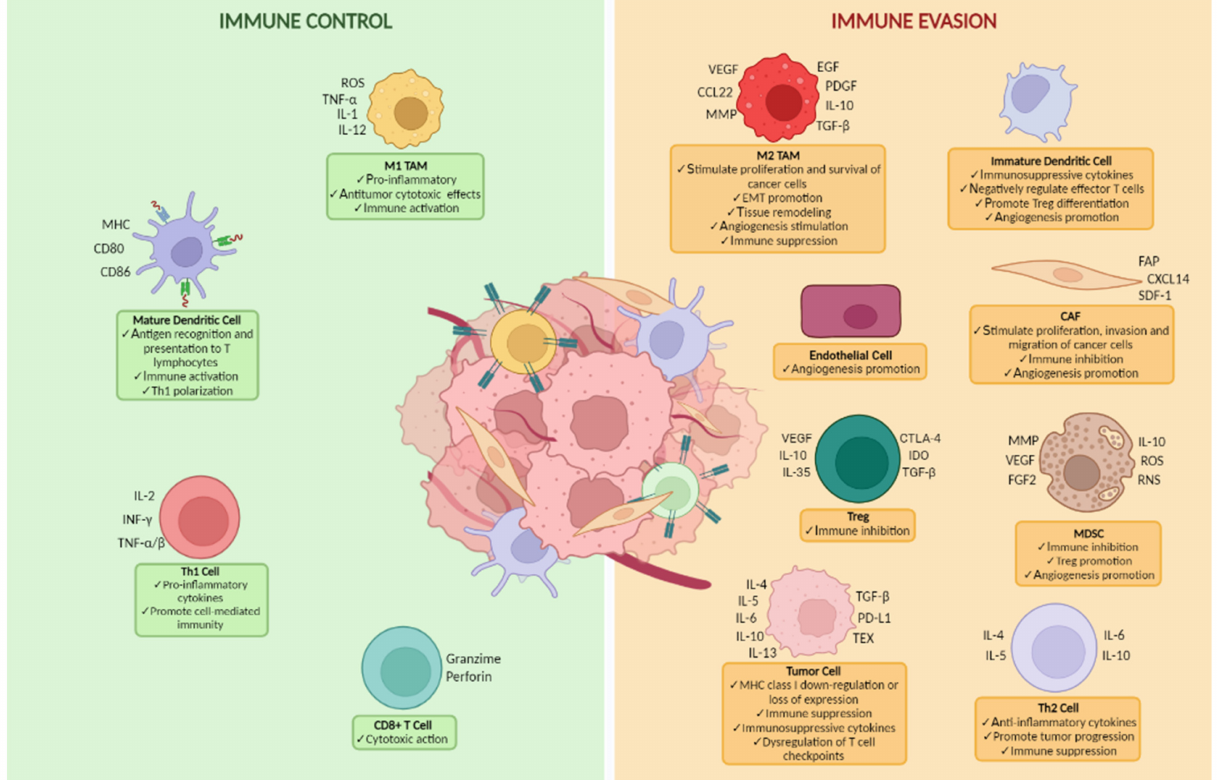
Figure 1. Cellular components and functions of the tumor microenvironment in ovarian cancer. The image was created with BioRender Software (https://biorender.com/ (accessed on 11 July 2022)). Abbreviations: TAM, tumor-associated macrophages; EMT, epithelial mesenchymal transition; CAF, cancer-associated fibroblast; MDSC, myeloid-derived suppressor